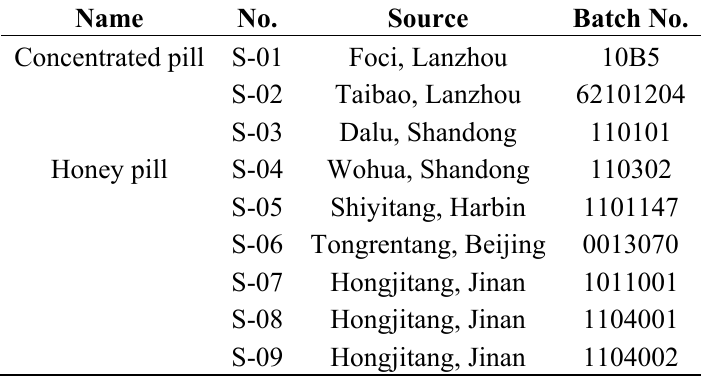
Table 6. Sources of all the samples ( Xiaohuoluo Pill ) used in this work. Name No. Source Batch